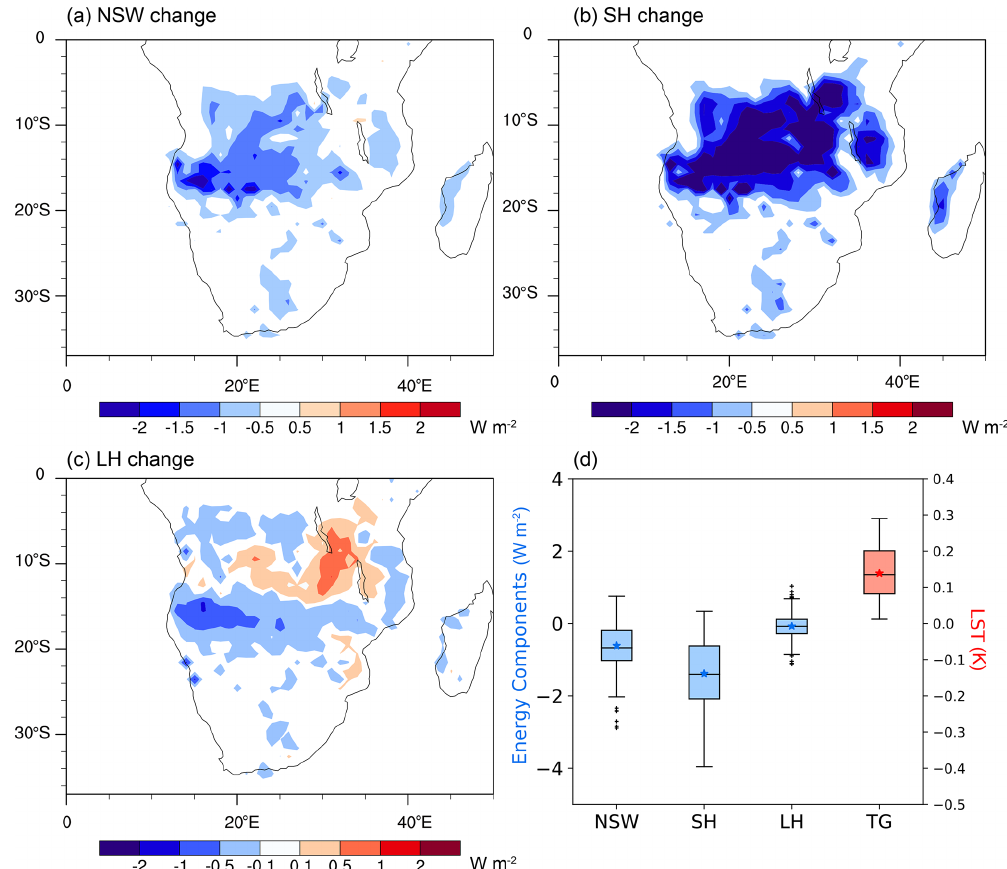
Figure 9. 2000–2013 annual fire effects on (a) NSW (Wm − 2 ) , (b) SH (Wm − 2 ) , (c) LH (Wm − 2 ) . (d) Box plot of annual fire effects on NSW, SH, LH, and TG (K) for grids with an annual burned fraction > 10% within SAF, with medians (middle bars), interquartile ranges (between 25th and 75th percentiles; boxes), maxima/minima (whiskers) within ± 1 . 5 × interquartile ranges, and outliers (“ + ”). The blue and red asterisks (*) denote the areal-weighted mean fire effects in